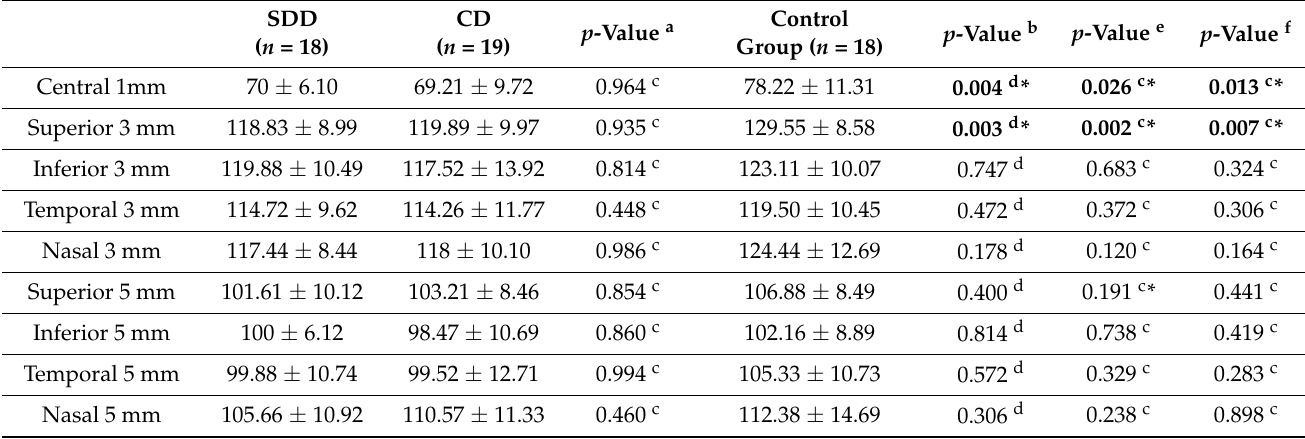
Table 2. Analysis of inner retinal thickness in eyes with subretinal drusenoid deposits (SDD), conventional drusen (CD), and control group. Thickness values are expressed in µ